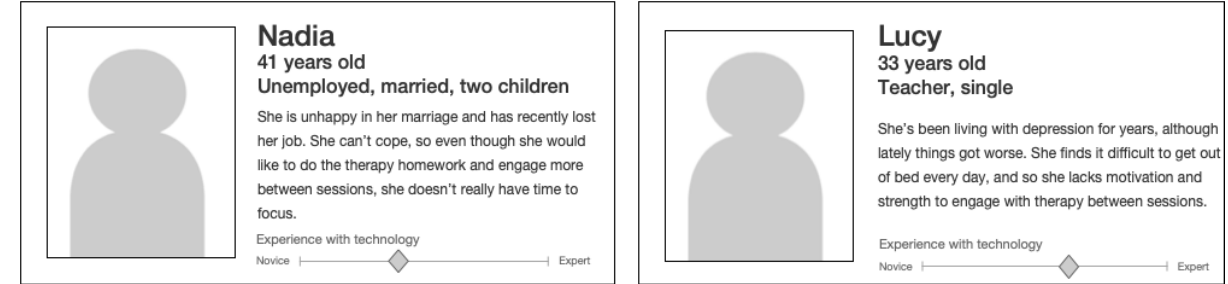
Figure 2. Example patient